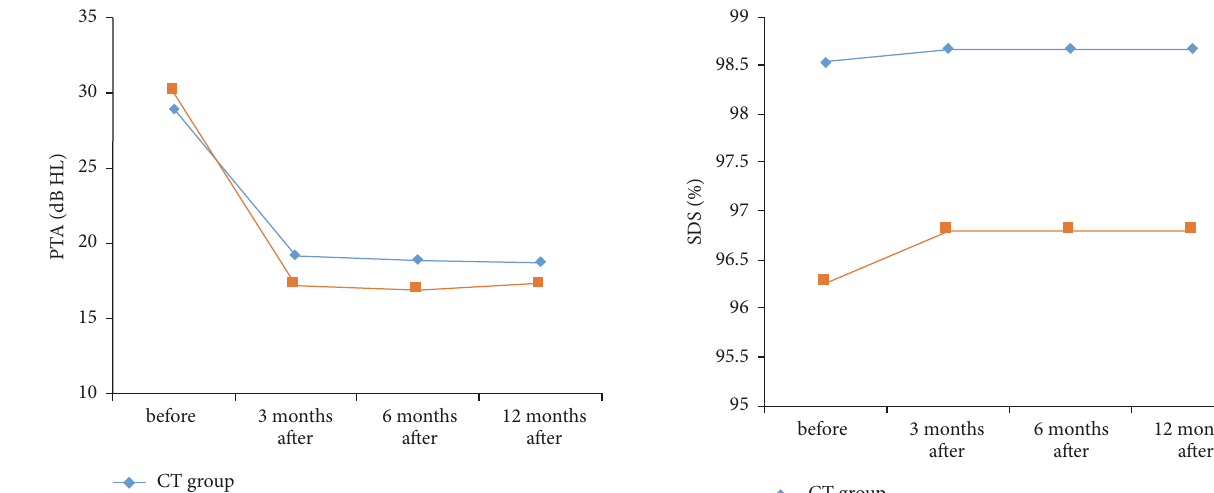
In total, postoperative tympanic membrane perforation was found in 10.0% of patients in the control group and 13.3% in case group with no significant difference ( 𝑃 = 0.500